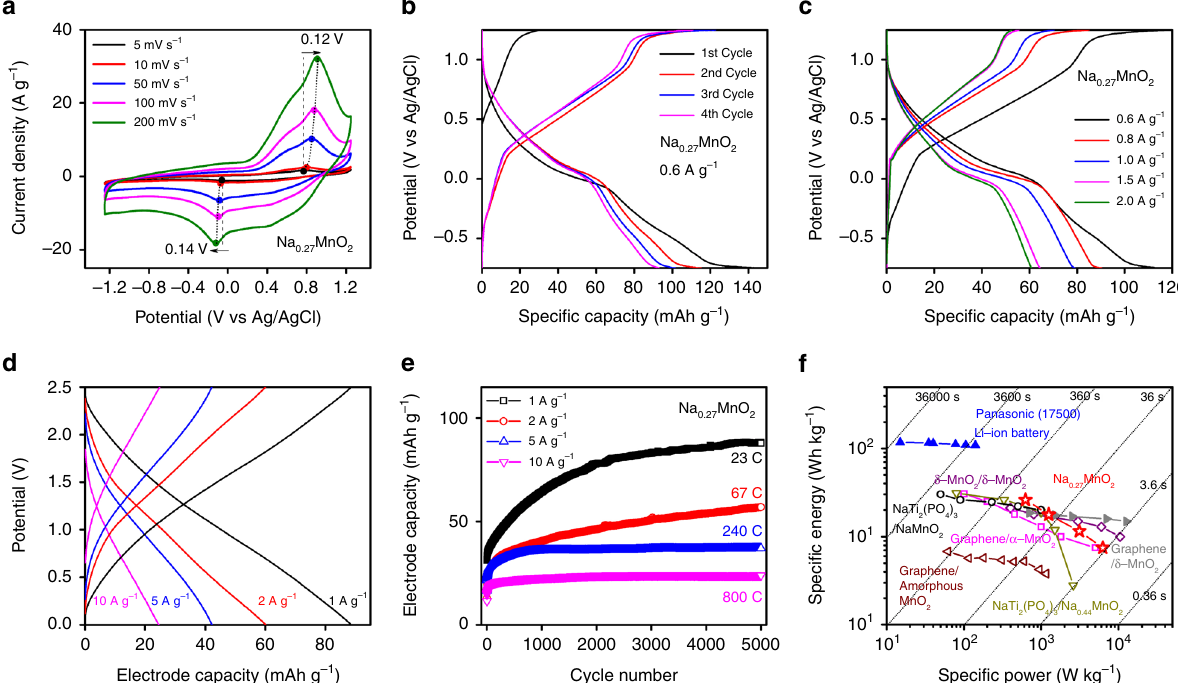
Fig. 4 Electrochemical measurements of Na 0.27 MnO 2 in half-cells and full-cells. Electrochemical half-cell measurements with a CV scans of Na 0.27 MnO 2 material between − 1.25V and 1.25V (vs Ag/AgCl) at various scan rates in 0.1M Na 2 SO 4 electrolyte; b CP tests of Na 0.27 MnO 2 material between − 0.75V and 1.25 V (vs Ag/AgCl) at a current density of 0.6 A g − 1 in 0.1M Na 2 SO 4 electrolyte with the intial four charge and discharge cycles c CP tests of Na 0.27 MnO 2 material between − 0.75 V to 1.25 V (vs Ag/AgCl) at current densities ranging from 0.6 to 2.0A g − 1 in 0.1 M Na 2 SO 4 electrolyte (2nd cycle data). Symmetric full-cell measurements with d charge and discharge electrode capacities of Na 0.27 MnO 2 material at the various current densities of 1 A g − 1 , 2A g − 1 , 5 Ag − 1 , and 10A g − 1 (after 5000 galvonstatic charge and discharge process unless speci fi ed otherwise); e electrode capacities of Na 0.27 MnO 2 as a function of cycle number up to 5000 at the current densities from 1 A g − 1 to 10A g − 1 ; f Ragone plot with gravimetric speci fi c energy and power of the symmetric Na 0.27 MnO 2 full-cell after 5000 galvanostatic cycles. The aqueous (empty symbols) and non-aqueous (solid symbols) devices are reported, and the gravimetric speci fi c energy and power are calculated by the mass of electrode materials except the Panasonic (17500) Li-ion